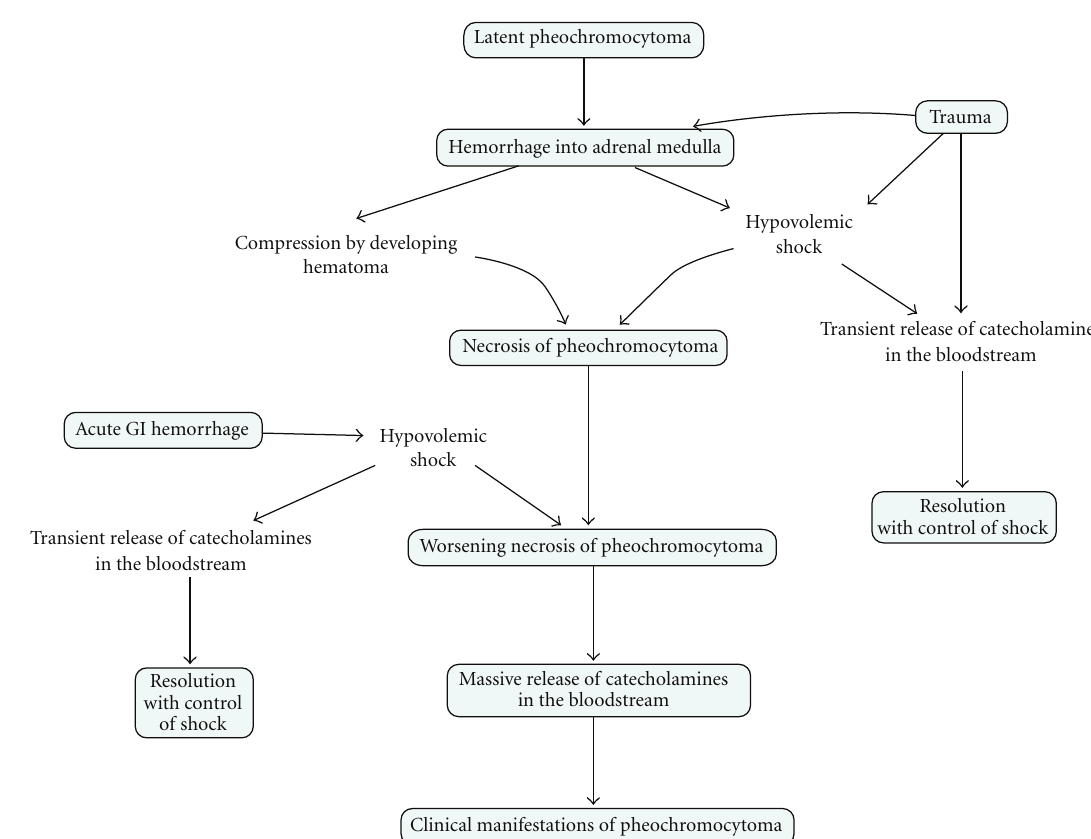
Figure 6: Pathophysiology of activation of “latent”